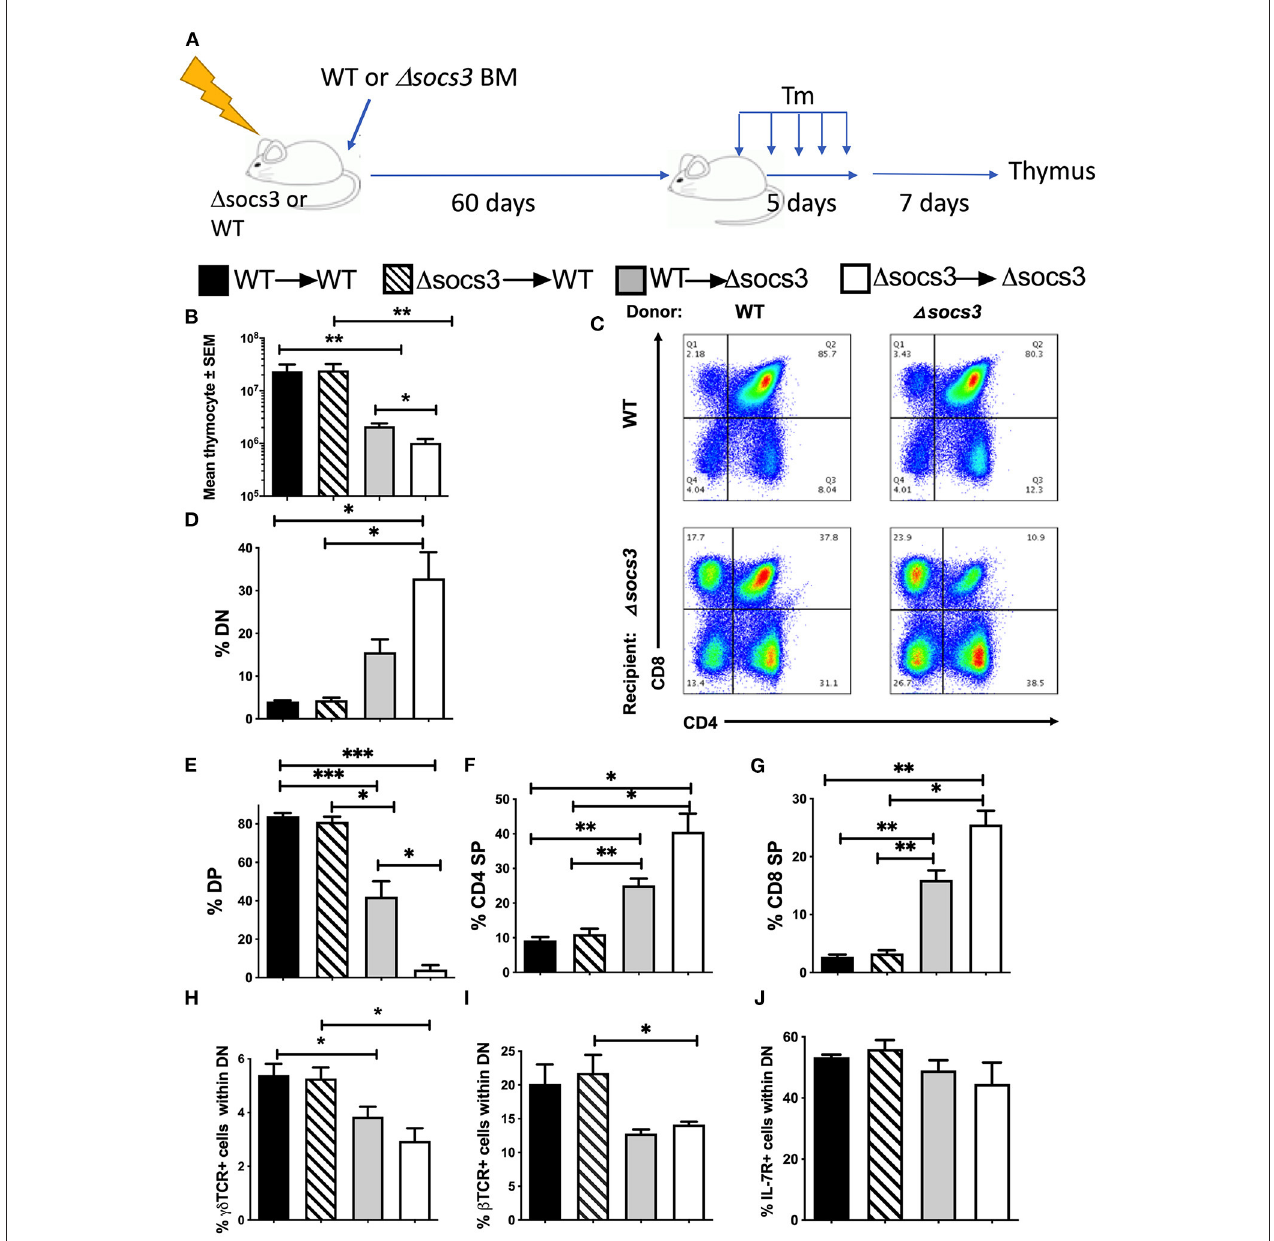
FIGURE 2 | SOCS3 expression by non-hematopoietic cells is central for thymus maintenance and T cell differentiation. (A) Radiation bone marrow (BM) chimeras were generated using WT and 1 socs3 mice as recipients or donors. Sixty days after transplantation, mice were treated with Tm and sacrificed 7 days after the last dose. (B) The mean thymic cell numbers ± SEM is depicted ( n ≥ 5 per group). Differences between groups are significant at * p ≤ 0.05, ** p ≤ 0.01 and *** p ≤ 0.01 Welch one way ANOVA. (C) Representative dot plots and (D–G) mean frequencies of DN, DP, CD4 SP, and CD8 SP thymocytes ± SEM in BM chimeric 1 socs3 and WT mice are depicted ( n ≥ 5 per group). Differences between groups are significant at * p ≤ 0.05, ** p ≤ 0.01 Welch one-way ANOVA. (H,I) The mean frequency of (H) γδ and (I) β TCR + cells within DN ± SEM BM chimeric mice is depicted. Differences between groups are significant at * p ≤ 0.05 Welch one-way ANOVA. (J) The mean % IL-7R + cells within DN population ± SEM in BM chimeras of 1 socs3 and WT is shown.